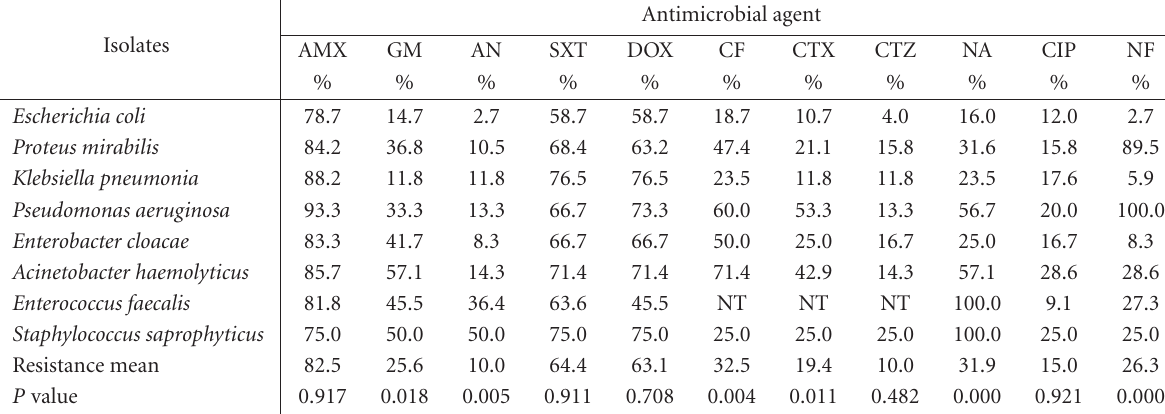
Table 2. Antimicrobial resistance percentage of 480 clinical bacterial strains isolated from urinary tract infections. AMX, amoxycillin; CF, cephalexin; CTX, cefuroxime; CTZ, ceftazidime; GM, gentamycin; AN, amikacin; SXT, cotrimoxazole; DOX, doxycycline; NA, nalidixic acid; CIP, ciprofloxacin; and NF,